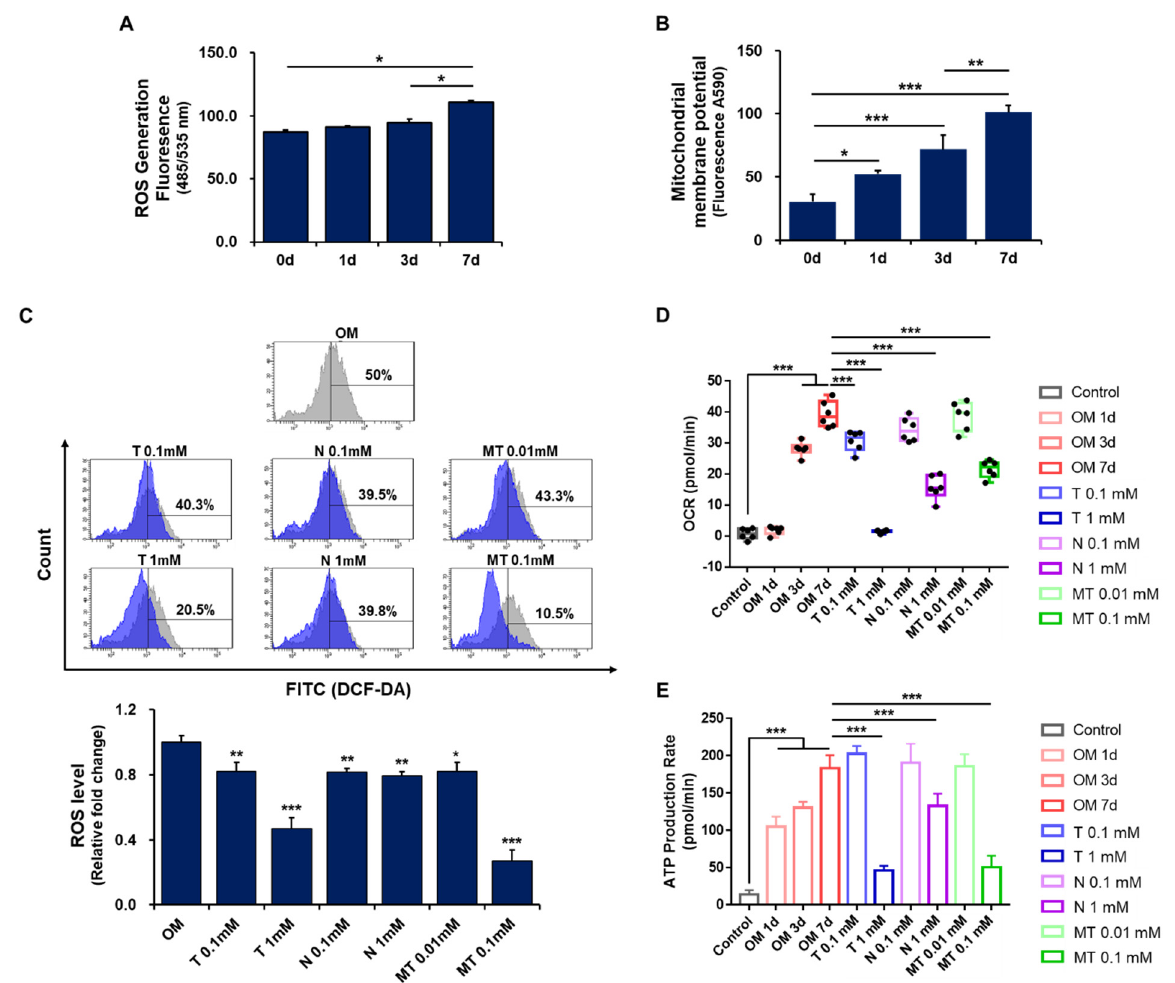
Figure 4. Effects of tiron on ROS production in osteoblast-differentiating hPDCs. ( A ) ROS production was significantly increased in hPDCs after 7 days of culture in osteogenic induction medium. ( B ) MMP was significantly increased in hPDCs in a time-dependent manner in osteogenic induction